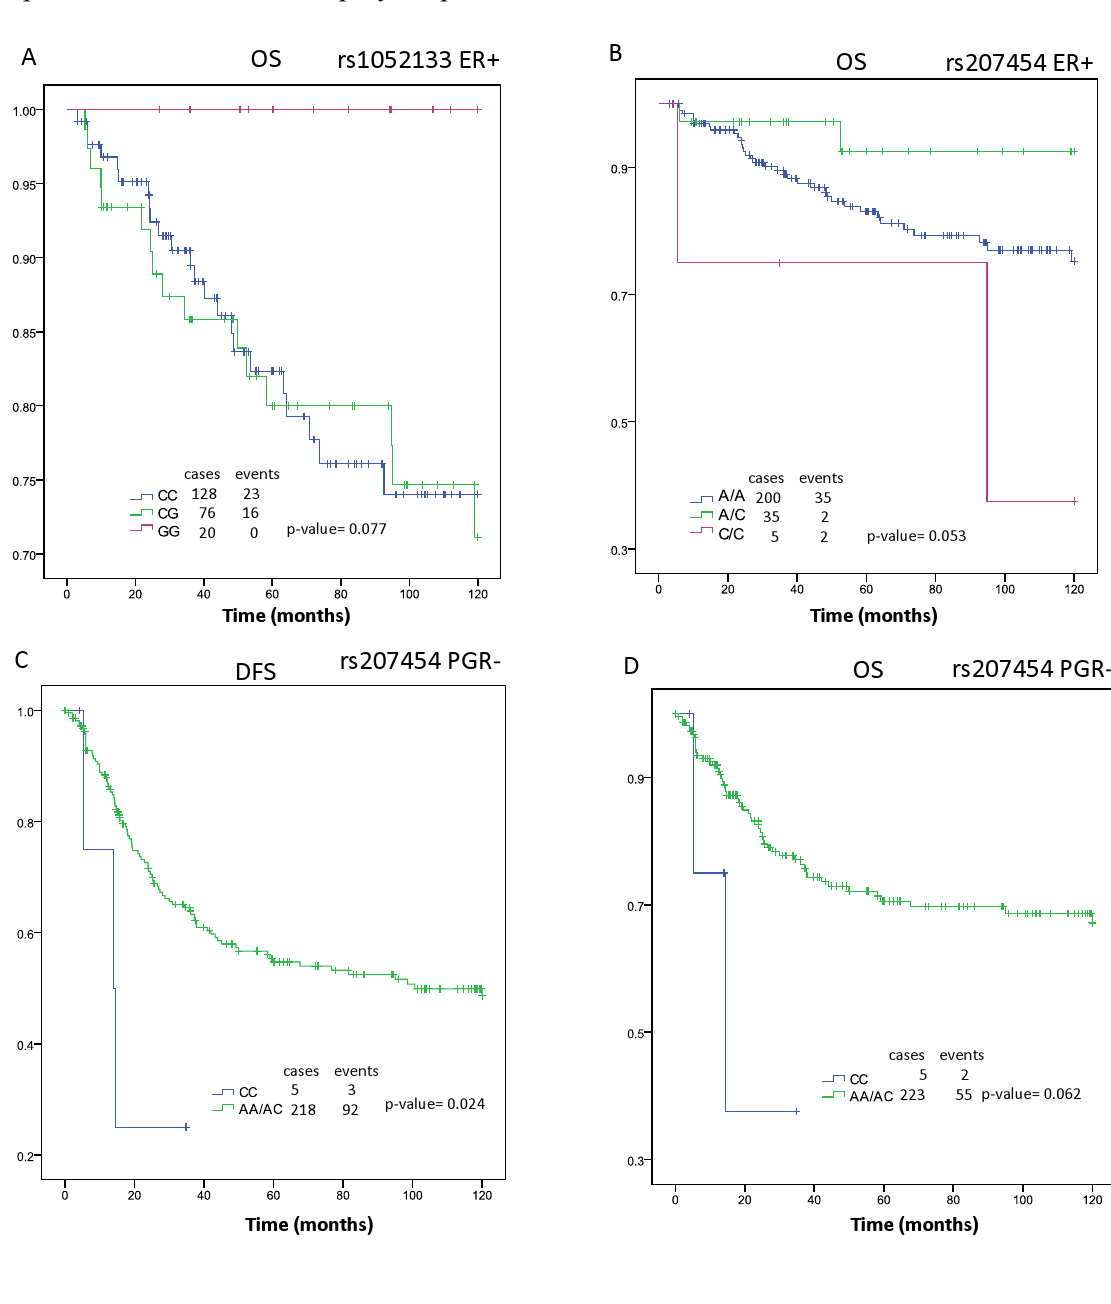
The polymorphisms rs1052133 and rs207454 show a trend toward significance in the OS analysis when the patients were ER+ ( p = 0.077 and p = 0.053, respectively) (Figure 2A,B). The analysis, as a result of the progesterone receptor (PGR) status, shows an association only in the case of the rs207454, with a significant value in the time of DFS ( p -value = 0.024) and a trend in the OS ( p = 0.062). Both cases present the lowest survival time in patients with the CC genotype and PGR − (Figure 2C,D). Figure 2. Kaplan-Meier analysis of rs1052133 and rs207454 polymorphisms. A and B : overall survival in the subgroup of estrogen receptor positive (ER+) patients in function of the polymorphisms rs1052133 and rs207454, respectively; C : Diseases-free survival (DFS) and D : overall survival (OS) in the subgroup of progesterone receptor negative (PGR − ) patients in function of the polymorphism